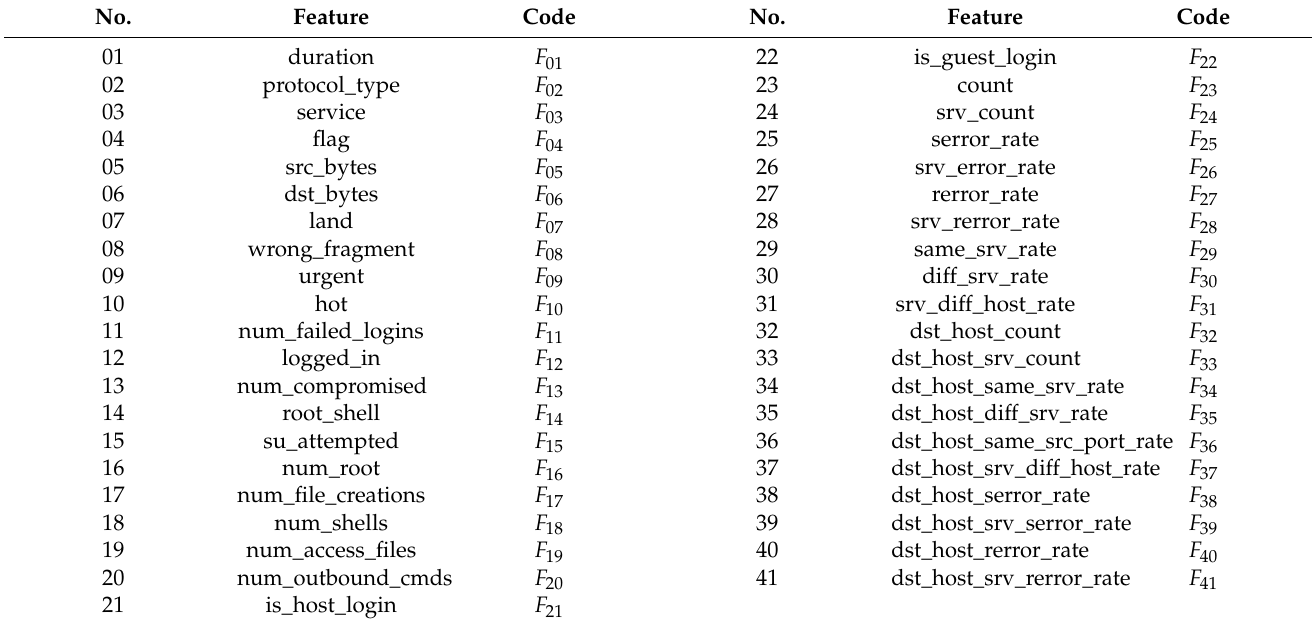
Table 2. List of all 41 features in the NLS-KDD dataset.